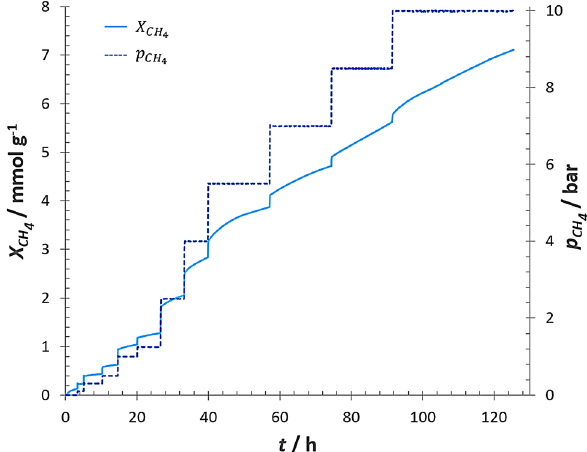
Fig. 9 Time dependent adsorption uptake response induced by a pressure profile of CH imposed onto Ni-MOF-74 at T = 303.15 4